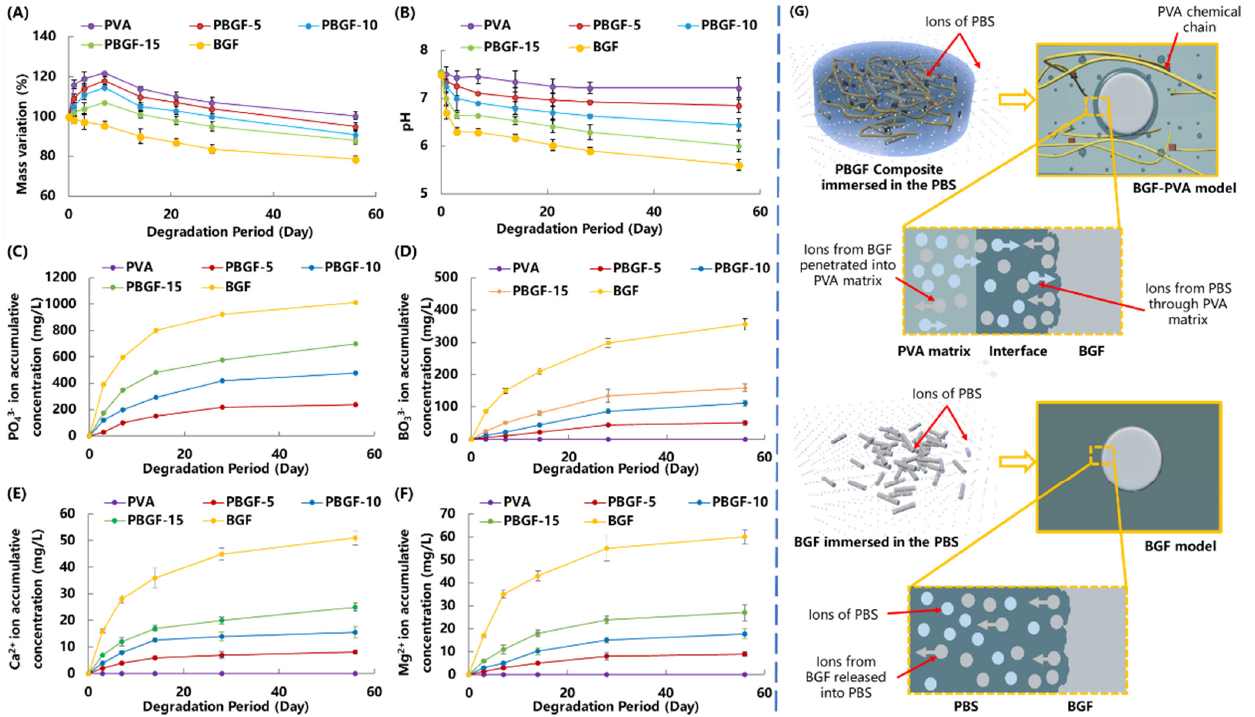
Figure 5. Degradation behavior of composites when immersed in PBS for 56 days: ( A ) The mass variation of PVA hydrogel and PBGF composites; ( B ) The pH value of PBS, where the BGF, PVA and PBGF composites were immersed; The ions of PO 43 − ( C ), BO 33 − ( D ), Ca 2+ ( E ), and Mg 2+ ( F ) released from BGF, PVA, and composites when immersed in the PBS solution; ( G ) The degradation mechanism diagram with ion movement for composites and pure biodegradable glass fiber when immersed in the PBS solution.